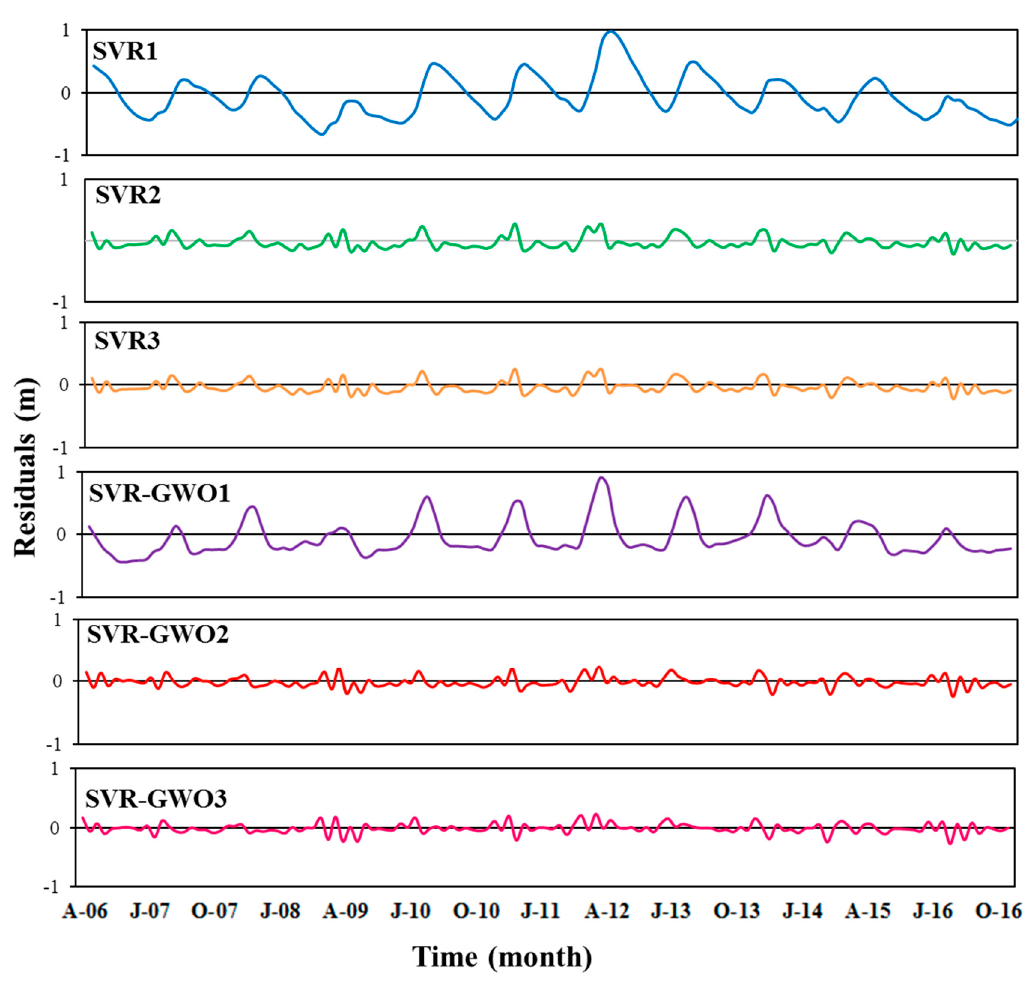
Figure 11. Time series of prediction error for the SVR and SVR-GWO models for the testing period.